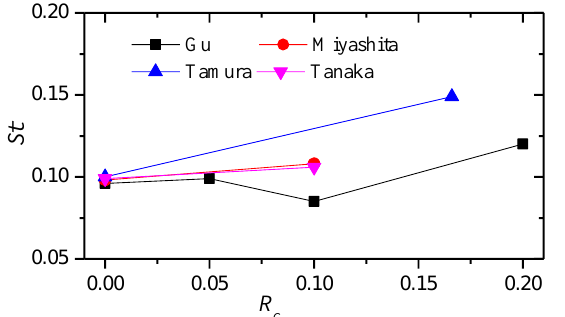
Figure 7. St number of chamfer model by existing studies [3,17,18,20].